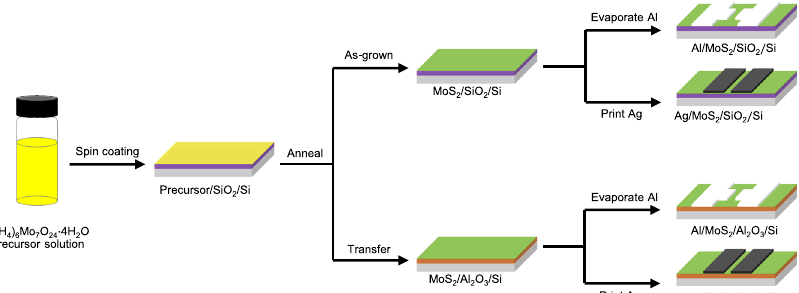
Fig. 1 Fabrication process of MoS 2 TFTs. Fabrication process of MoS 2 TFTs with thermal evaporated Al (top) and EHD jet printing technique (bottom) with SiO 2 and Al 2 O 3